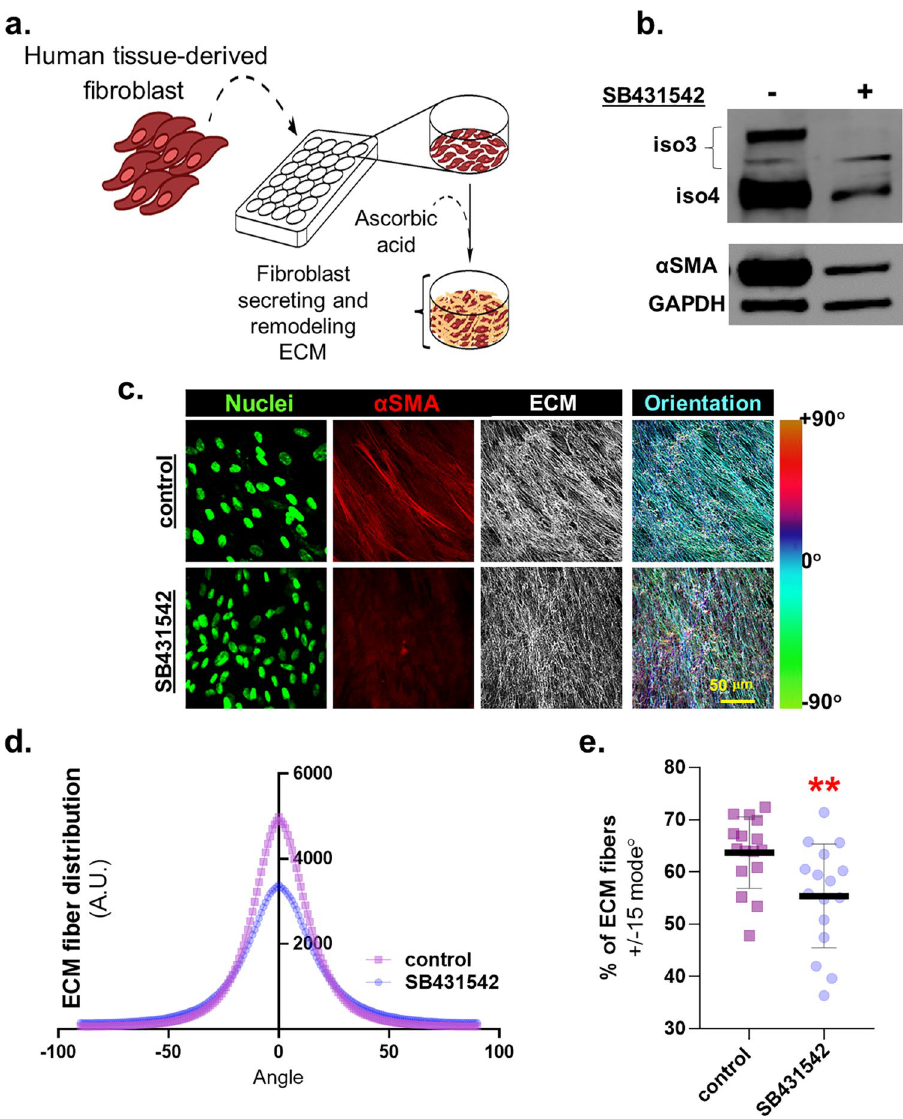
Figure 2. Inhibition of TGFβ1 signaling reduces CAF iso3 & iso4 expression and d-ECM alignment. ( a ) Schematic of 3D fibroblastic cell-derived ECM model used to assess assorted CAF function and/or traits. ( b ) Representative Western blot, using lysates collected at the end of ECM production, and blotted for palladin iso3 and iso4 as well as αSMA expression in vehicle vs. SB431542 treated CAFs. GAPDH served as loading control. ( c ) CAF-derived ECMs were treated during ECM production as in ( b ); shown are representative images of reconstructed confocal image stacks of human fibroblasts in 3D cultures. Images show dye-labeled nuclei in green, immunofluorescently-labeled αSMA (in red), and fibronectin (ECM in white). Scale bar: 50 microns. Last column shows pseudo-colored ECM, depicting corresponding fiber angles distribution, referenced to tone/ angle bar on the right; with cyan fibers as the mode angle. Note how ECM fiber analysis of CAFs cultured in the presence of SB431542, included additional fiber color tones suggestive of broader angle distribution compared to control condition. ECM analyses of images acquired in ( c ) were conducted measuring: ECM fiber angle distributions ( d ) and percentage of ECM fibers out of total fibers at 15° from the mode angle ( e ). Data presented were derived from 6 biological replicates (n = 6) and a minimum of 5 images acquired per sample. The Mann Whitney test was used to determine statistical significance. **p =